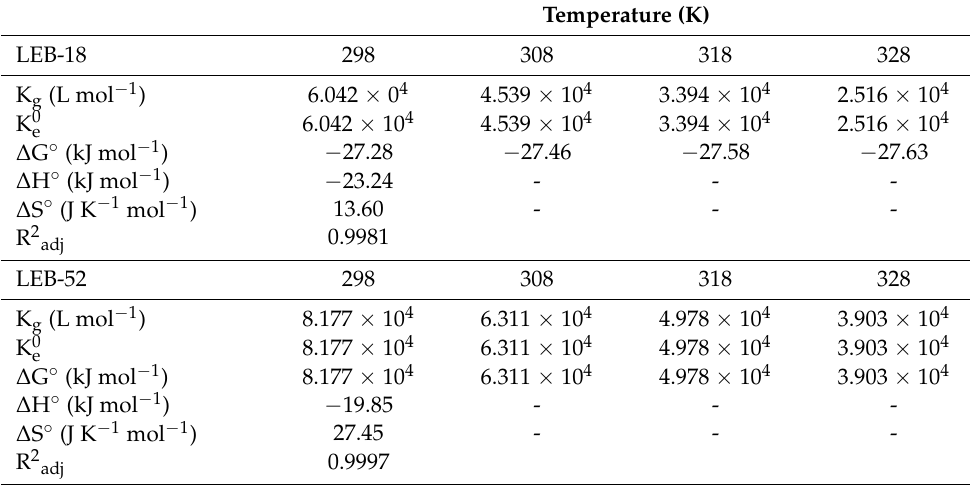
Table 5. Nd(III) adsorption thermodynamic parameters onto LEB-18 and LEB-52 biosorbents. Temperature (K) LEB-18 298 308 318 328 K g (L mol − 1 ) 6.042 × 0